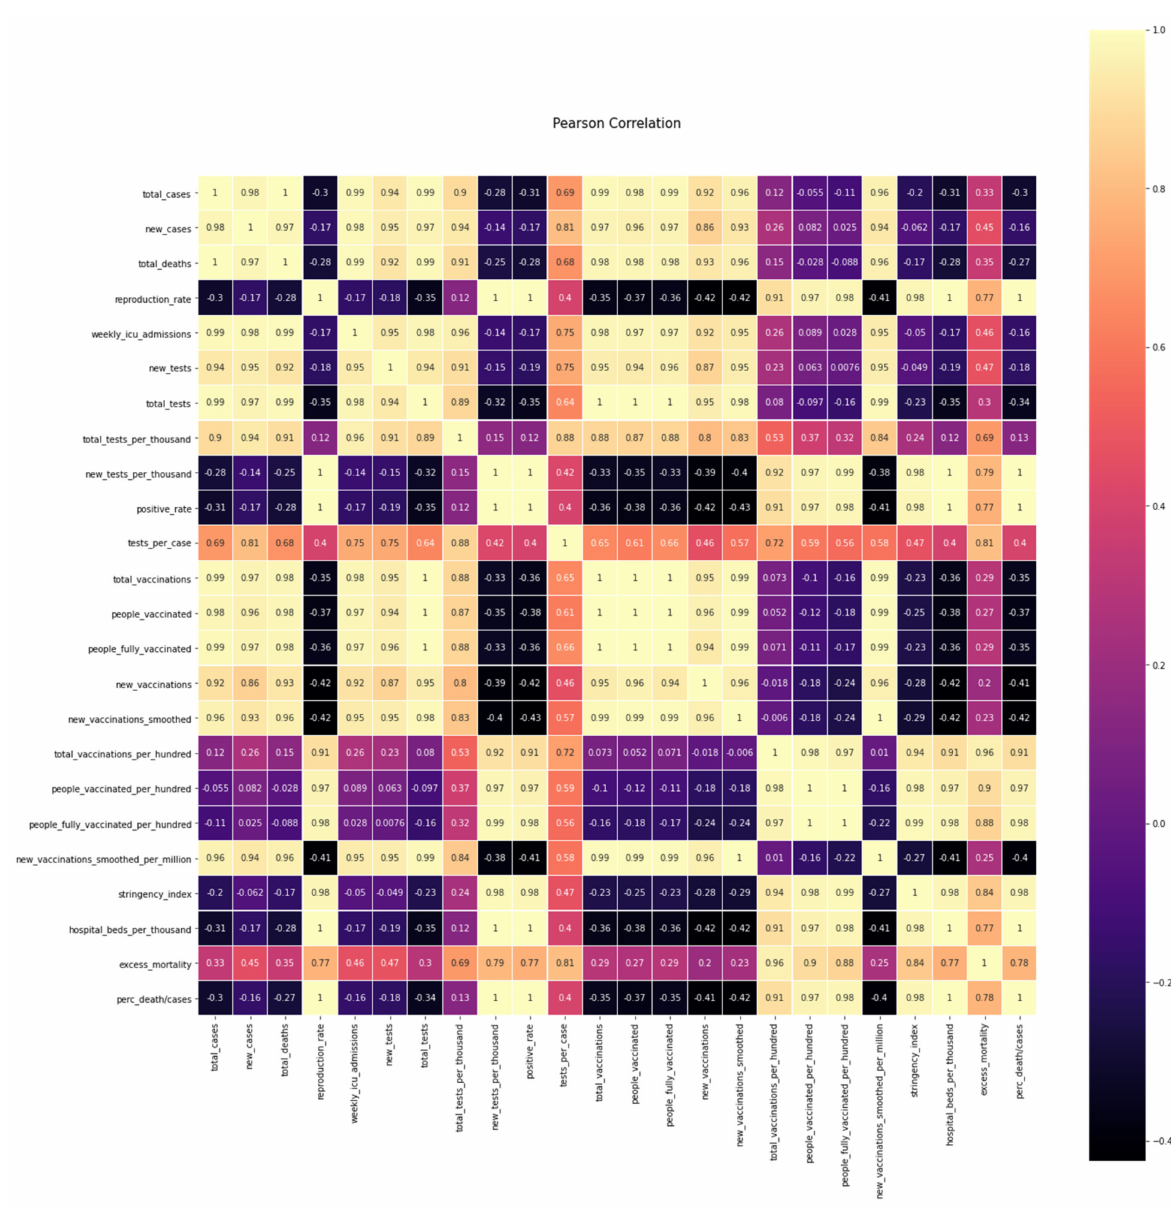
Figure 7. Pearson correlation